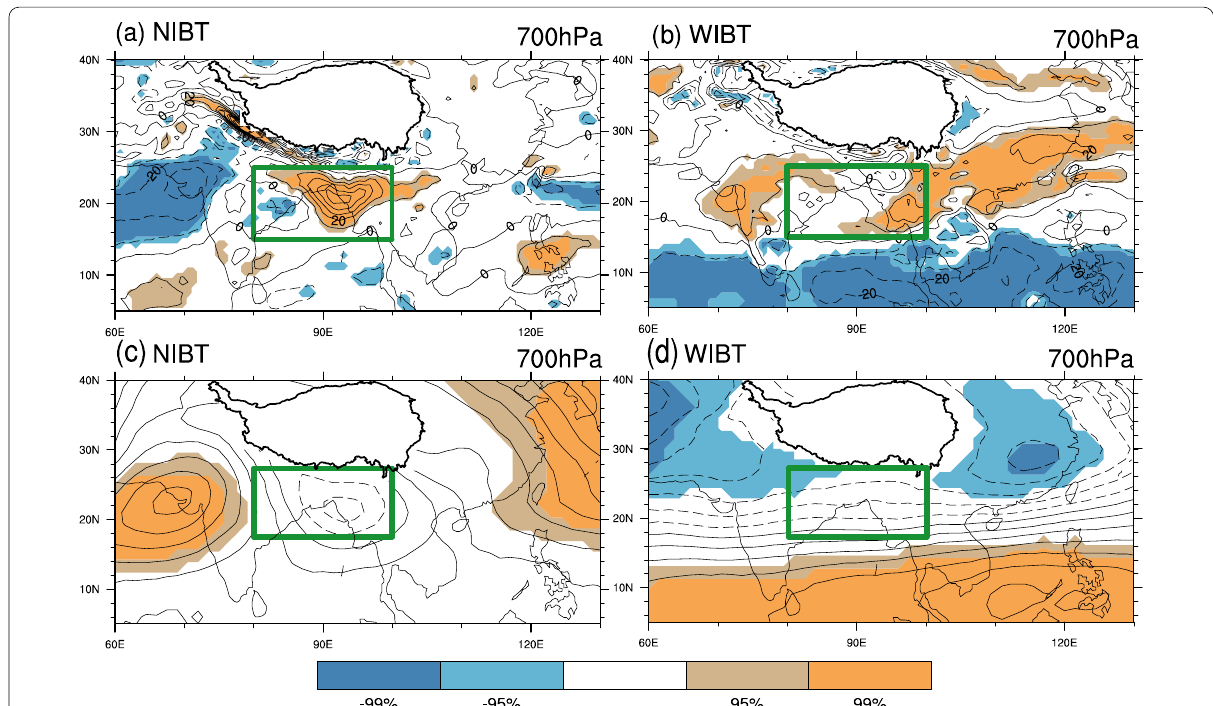
Fig. 3 700‑hPa vorticity anomalies (units: s − 1 ) regressed upon the ( a ) NIBT and ( b ) WIBT indices in winter for the period 1979–2019. c and d As in a and b, but for 700‑hPa geopotential height anomalies (units: gpm). The green box (15–25 °N, 80–100 °E) in ( a and b ) is the key region for defining the vorticity‑based IBT index. The green boxes (17.5–27.5 °N, 80–100 °E) in c and d are the key region for defining the geopotential height‑based IBT index. Shadings denote positive/negative anomalies significant at the 95% and 99% confidence levels as shown by the color